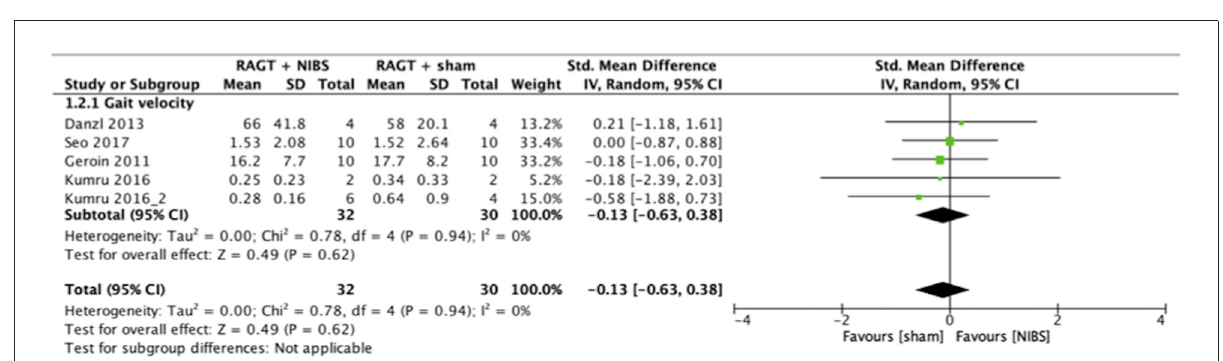
FIGURE3 Forest plots: RAGT + NIBS vs. RAGT + sham with outcomes of activities (gait velocity) based on the International Classification of Functioning, Disability, and Health. NIBS, non-invasive brain stimulation; RAGT, robot assisted gait training.